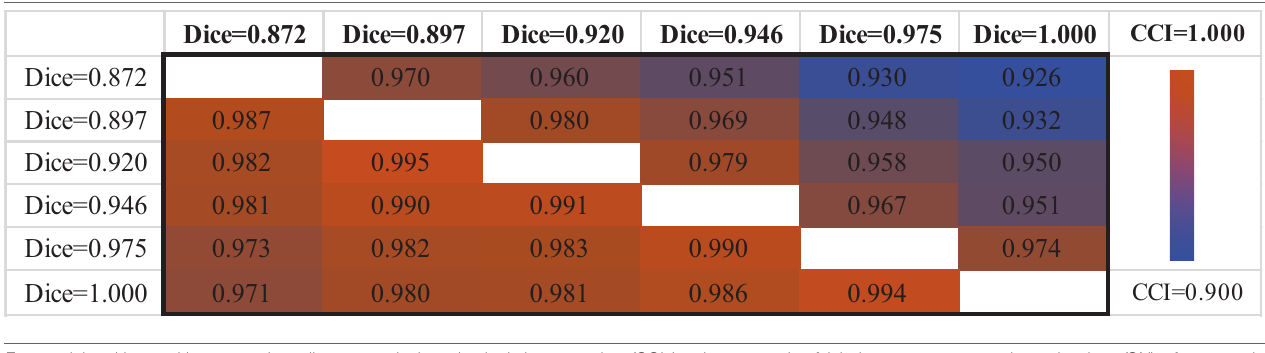
TABLE 2 | Classification consistency for two sets of